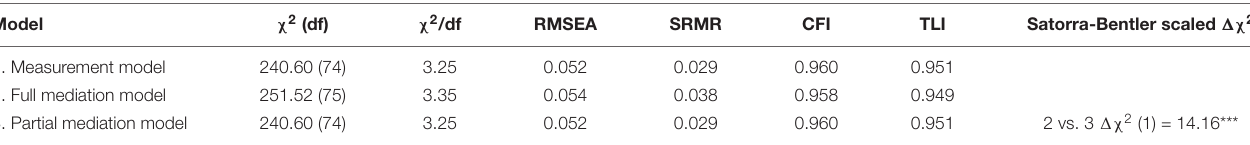
TABLE 2 | Fit indices of measurement model, structural models, and model comparison.